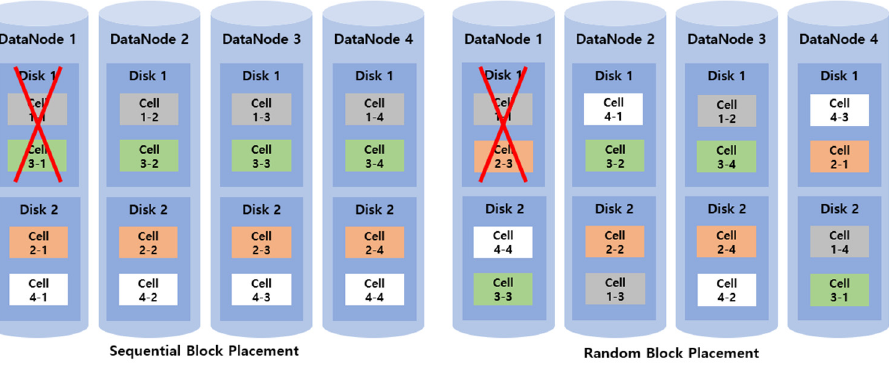
Figure 16. Examples of sequential ( left ) and random ( right ) block placement disk fault. According to the basic rule of the block placement, four cells are stored in a different DataNode and disk. Blocks are placed sequentially in the order (DataNode 1, Disk 1) → (DataNode 2, Disk 1) → (DataNode 3, Disk 1) → (DataNode 4, Disk 1) in the sequential block placement technique, and blocks are randomly placed in the DataNodes and disks in the random block placement technique.